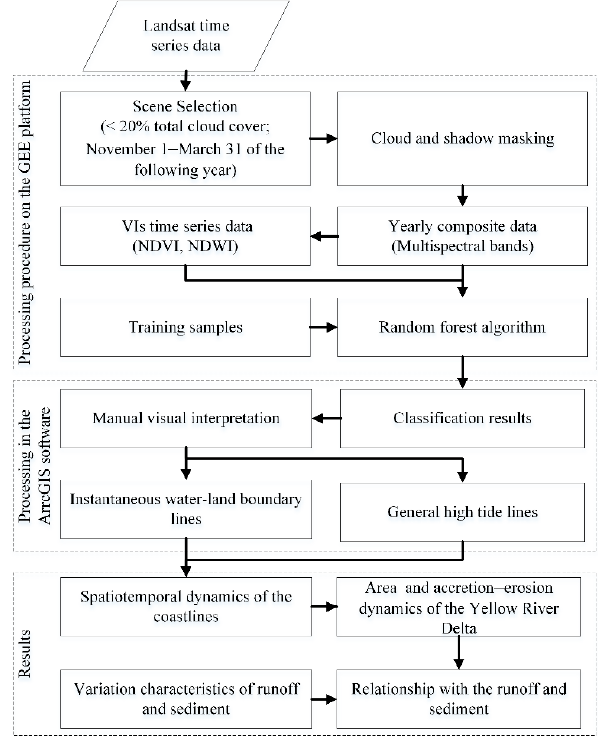
Figure 3. Workflow of coastal accretion–erosion dynamics and the relationship with runoff and sediment based on Landsat time series and runoff and sediment data in this study. GEE: Google Earth Engine.